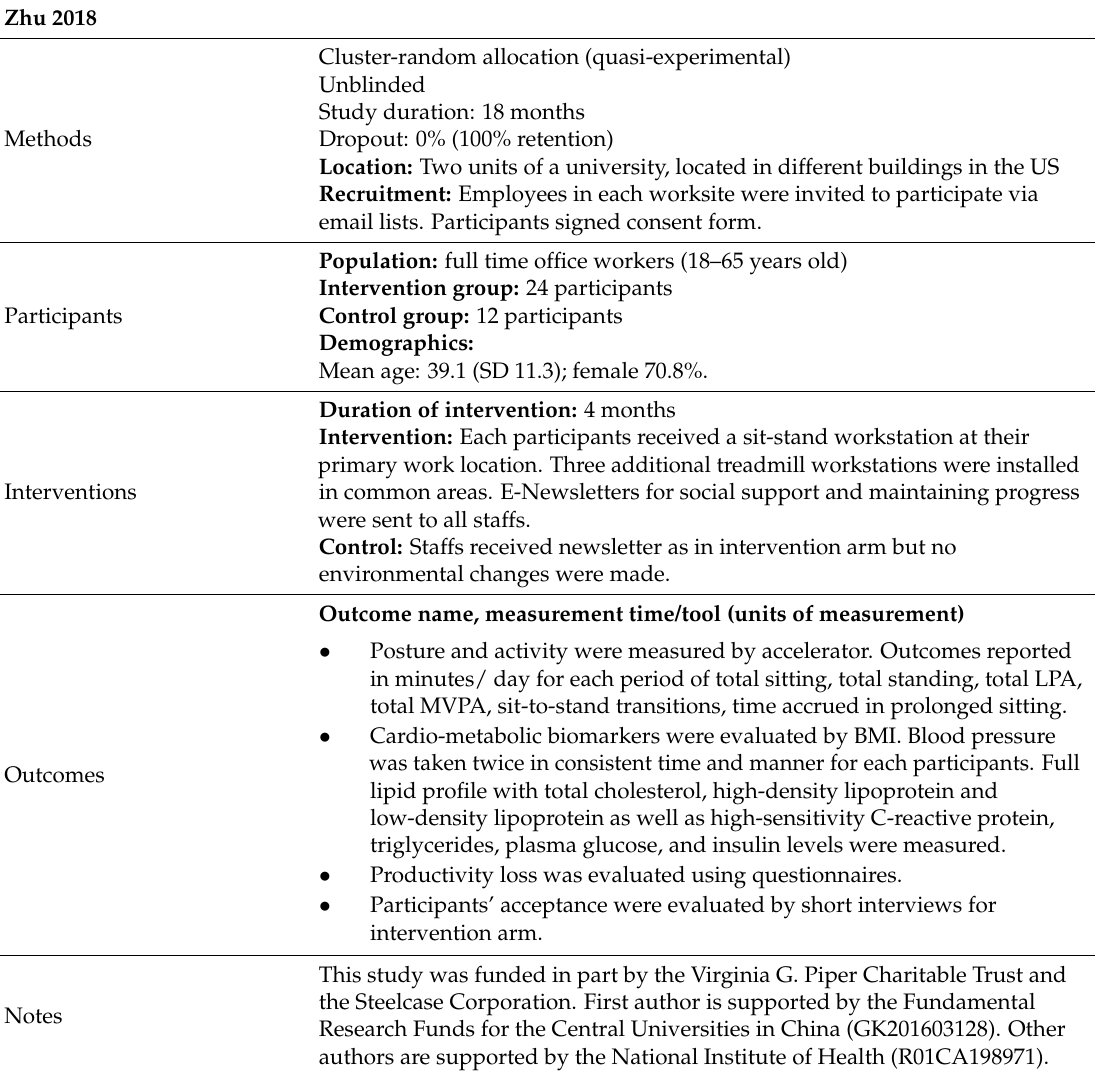
Table A2. Characteristic of Included